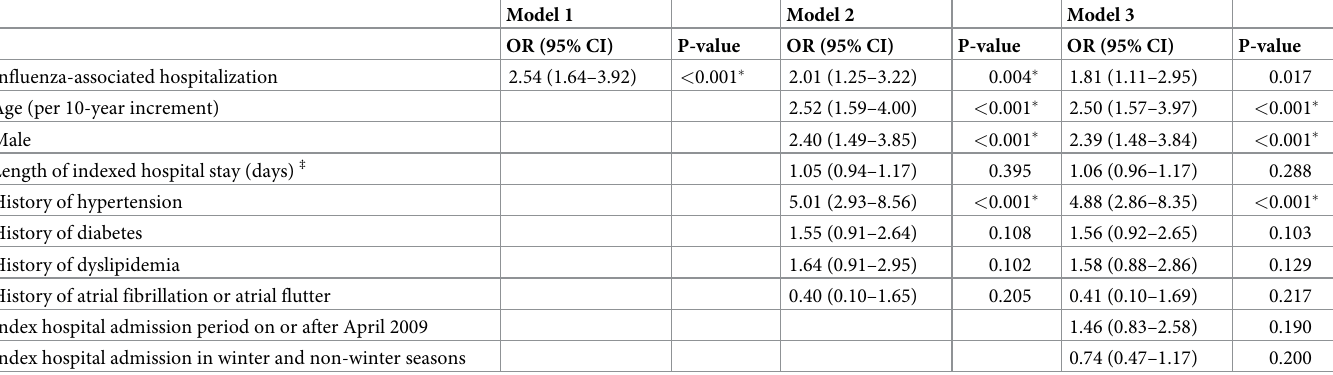
Table 3. Results from logistic regression analysis of subsequent hospitalization for acute myocardial infarction within 12 months following discharge from hospital for severe influenza (exposed), compared with elective orthopedic surgery (non-exposed).